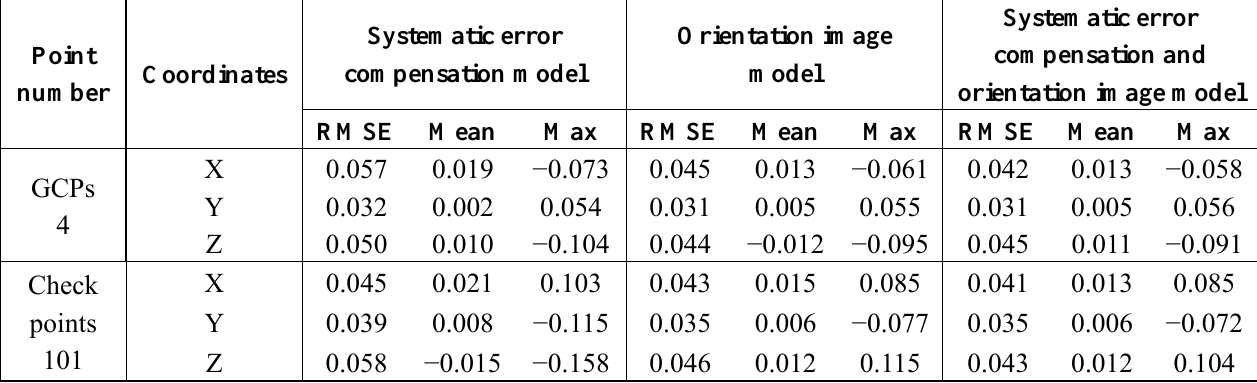
Table 1. Error statistics of bundle adjustment of the Taigu test field (Unit: